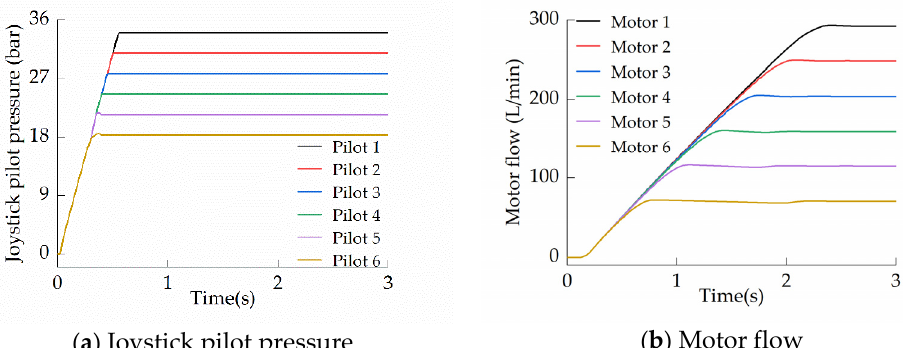
Figure 10. Proportional relationship of joystick-motor.